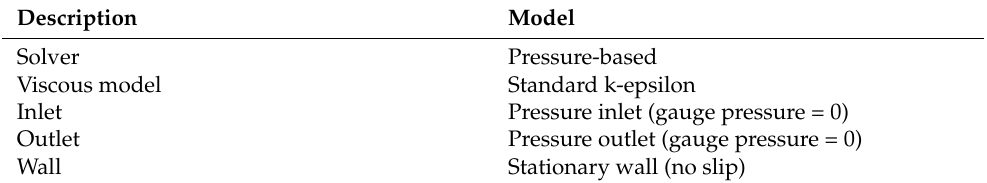
Table 2. CFD model description.